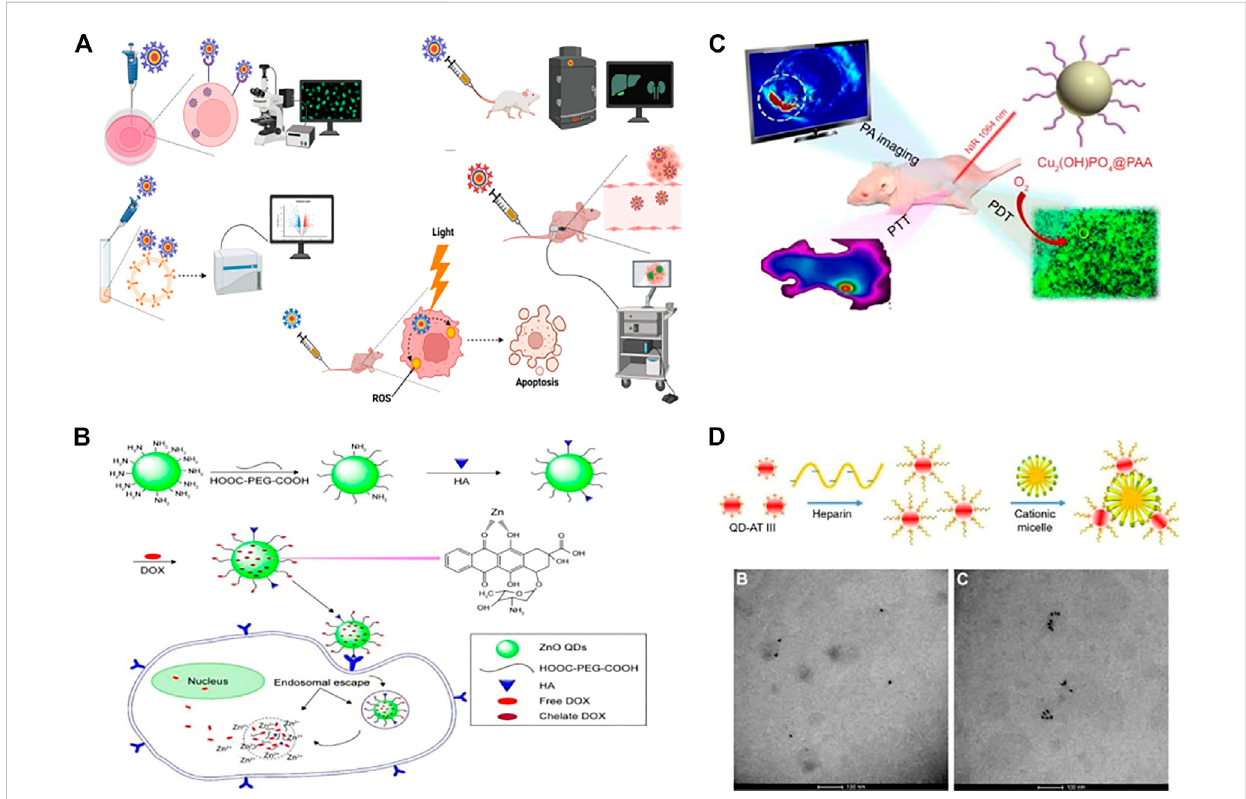
FIGURE 3 Biomedical applications of quantum dots (QDs). (A) QDs were used for intracellular imaging, in vivo imaging, fl uorescence-activated cell sorting, photodynamic therapy, and traceable drug delivery. (B) QDs were used for drug delivery, such as the hyaluronic acid-ZnO QD-polyethylene glycol (HA- ZnO-PEG)material.ThisdrugdeliverysystemcanreleaseDOX(doxorubicin)inacidiccells. (C) QDscanbeusedforimagingandenableacombinationof photodynamictherapy and photothermal therapy as well as photoacoustic imaging. (D) QDs have been used in sensors. TEMimages of QDs-AT III- heparin without CTAB can be easily distinguished from TEM images of QD aggregates with CTAB after quantum dot synthesis and